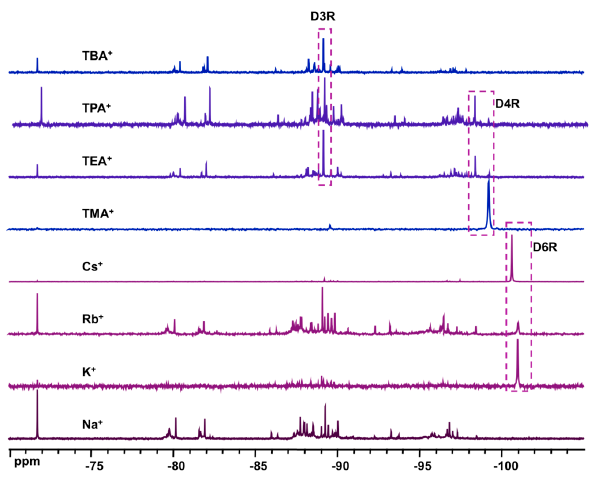
Figure 5. 29 Si NMR spectra of equilibrated solutions in the system 1 α -CD:6 TEOS:6 base:300 D 2 O, base = NaOH, KOH, RbOH, CSOH, TMAOH, TEAOH, TPAOH, and TBAOH, which shows the occurrence of D6R (ca. 101 ppm) with the presence of large alkali cations (K + , Rb + , and Cs + ).